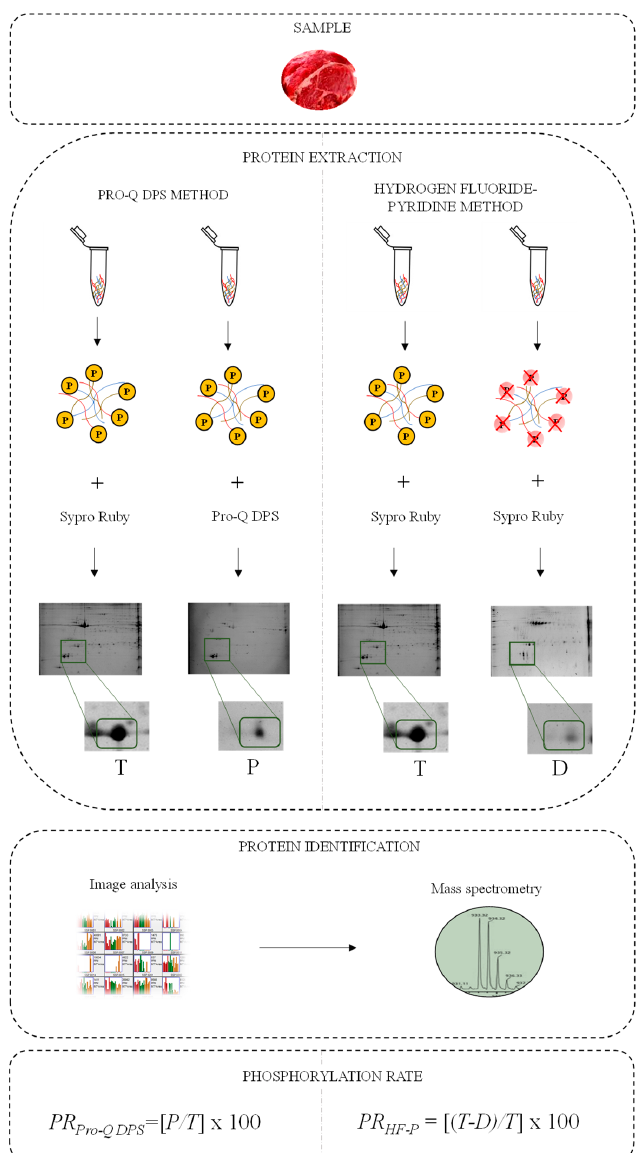
Figure 1. Workflow and experimental design of the quantitative phosphoproteomic analysis of meat proteins on 2-DE gels from LT muscle by Pro-Q DPS and HF-P methods. Meat proteins were separated by 2-DE and visualized with Sypro Ruby and the gel image was subsequently scanned to obtain meat protein reference patterns and total protein volume of spots ( T ). Phosphorylated patterns were assessed from untreated sample stained with Pro-Q DPS stain that binds to phosphate groups to identify phosphorylated proteins and consequently obtain the phosphorylated spot volumes ( P ). Treatment of chemical dephosphorylation with HF-P following staining with Sypro Ruby was performed to obtain the pattern of dephosphorylated proteins and their volumes ( D ). Individual protein spots of gels were selected, extracted from gels and identified by MALDI-TOF and MALDI- TOF/TOF MS. Pro-Q DPS and HF-P methods were used to evaluate the phosphorylation rate ( PR